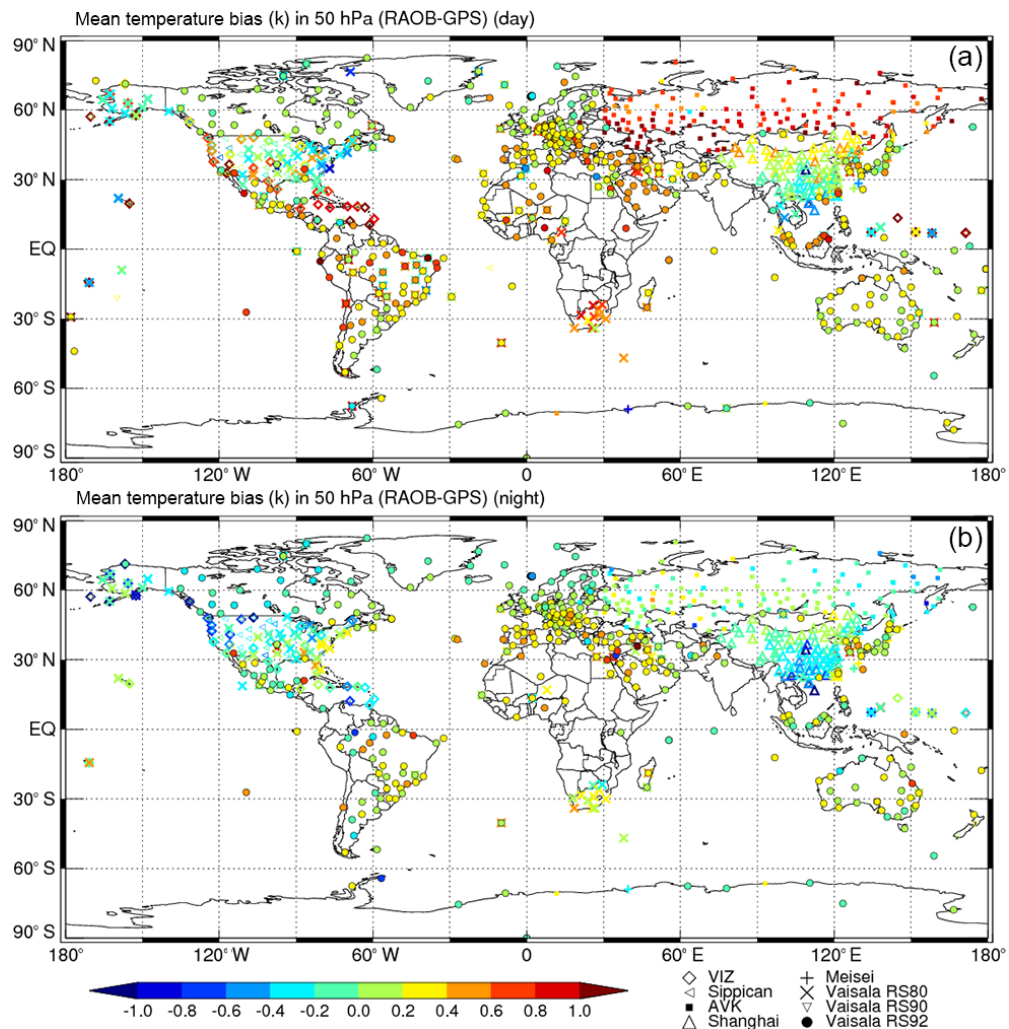
Figure 2. Mean RAOB–RO temperature biases at 50hPa for the RAOB–RO ensembles from June 2006 to April 2014 for (a) daytime, and (b) nighttime. Only those stations containing more than 50 RAOB–RO pairs are